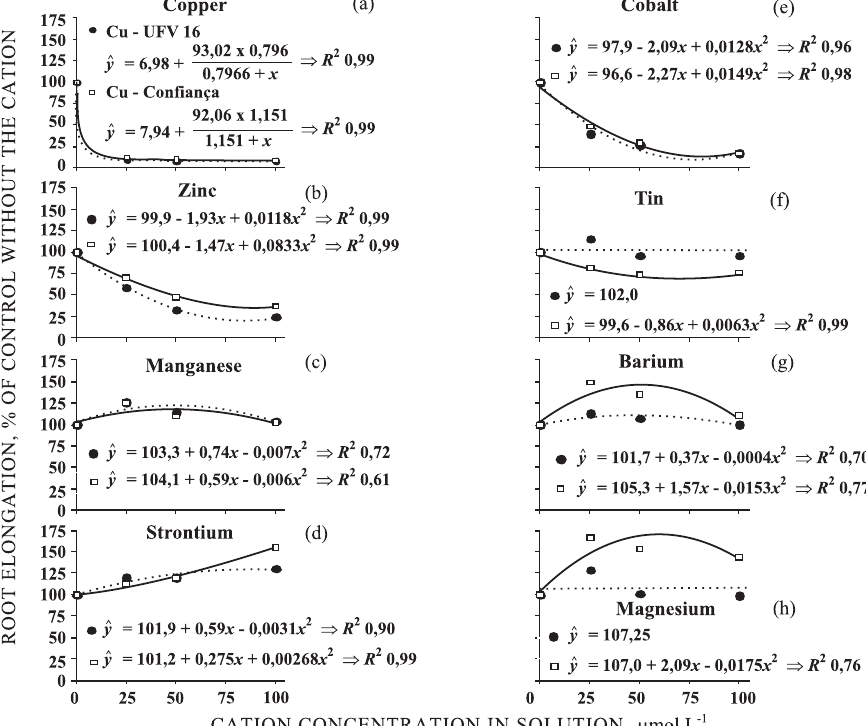
Figure 1. Relative root elongation of soybean cultivars UFV-16 and Confiança as a function of increasing doses of divalent cations in a CaCl 500 mmol L -1 (pH 4.5) basal solution, in the absence of Al. Error bars 2 represent standard error (n =